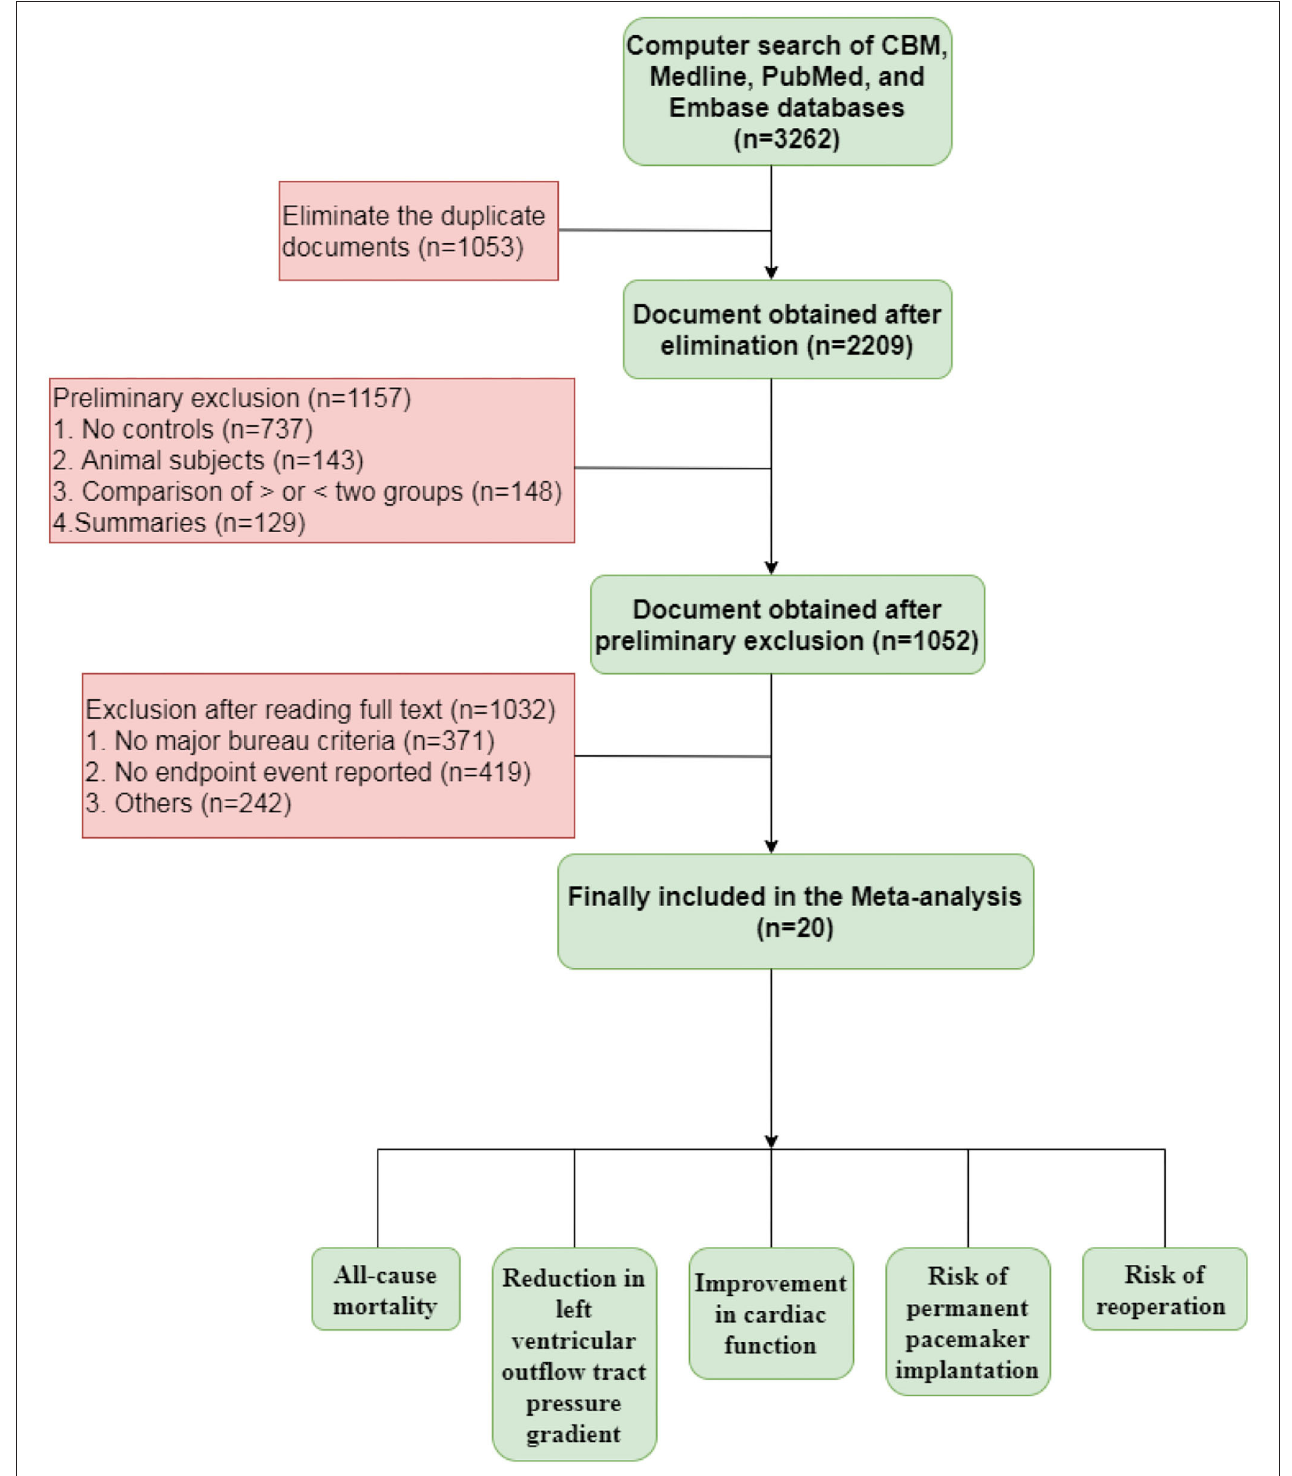
FIGURE 1 | The flowchart of the